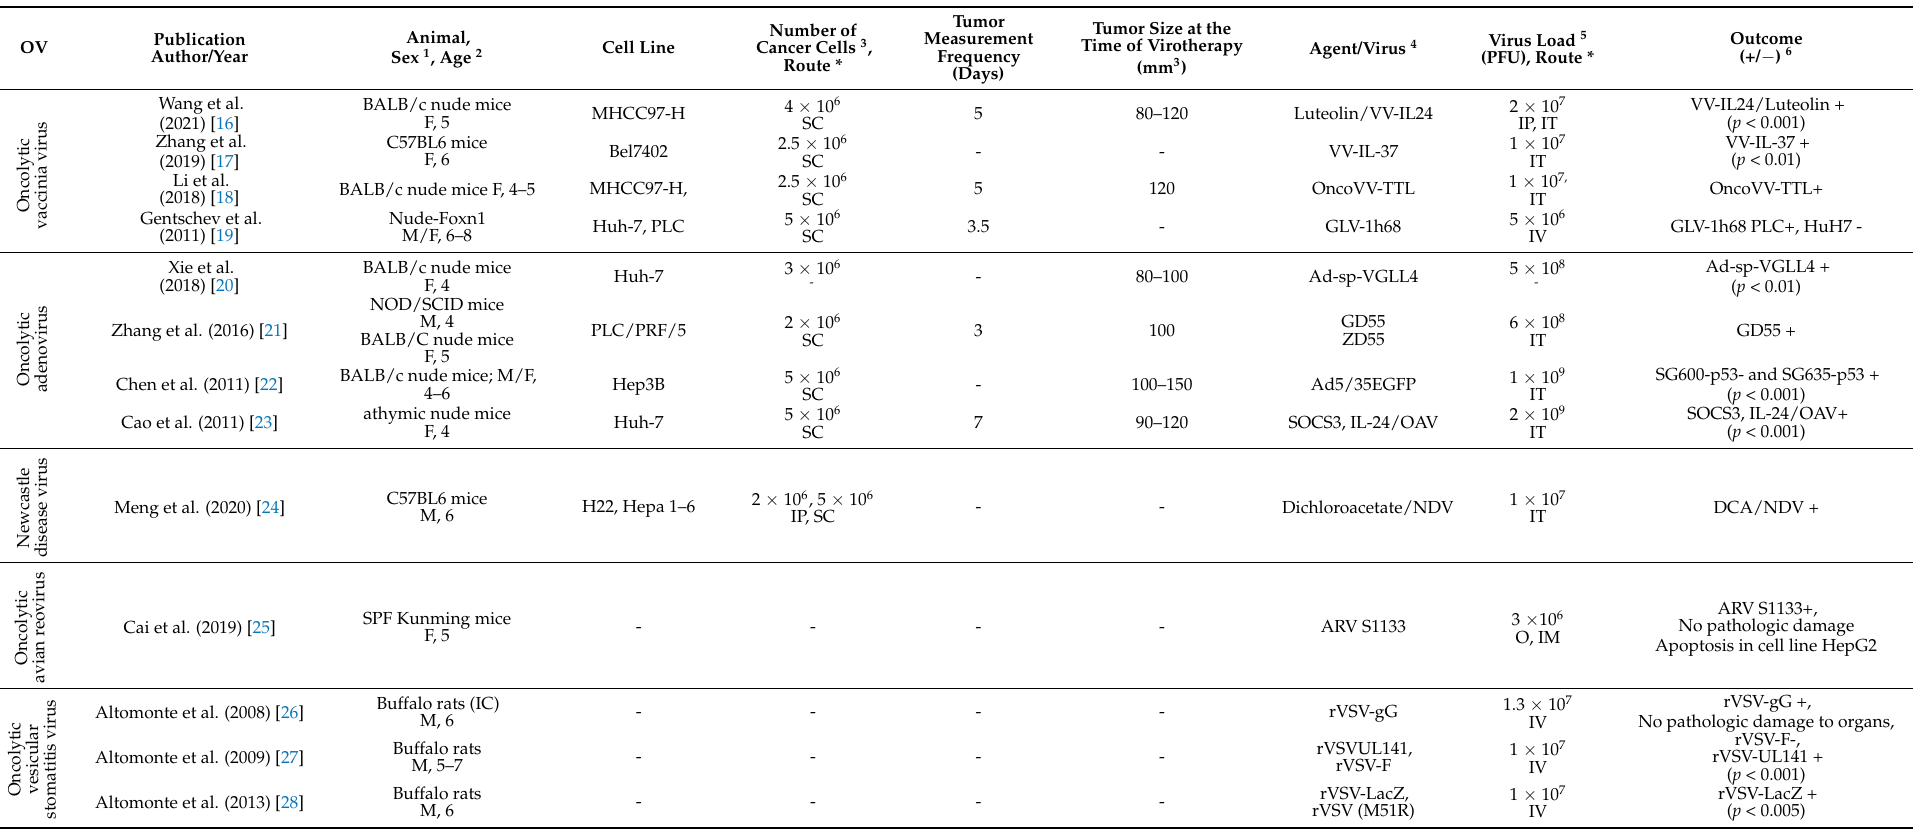
Table 1. Summary of the experimental details of the oncolytic virus studies reviewed